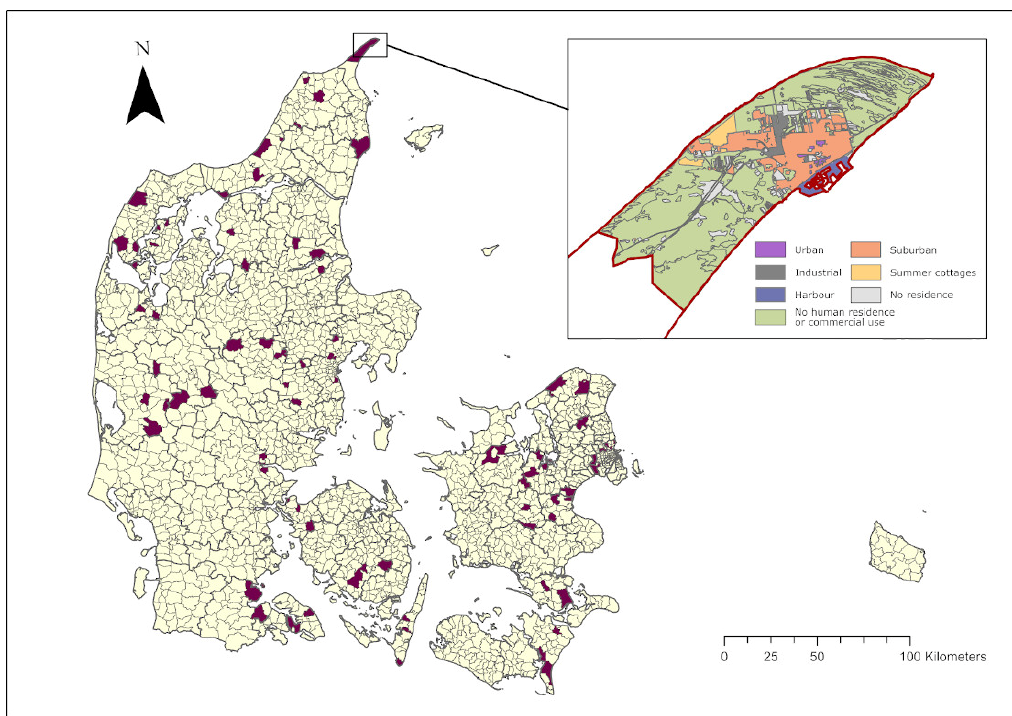
Figure 1. Sampled areas in Denmark (purple)—32 municipalities with 3 parishes in each. Skagen Parish is shown with habitat types. Based on map data provided by The Danish Agency for Data Supply and Efficiency, Copenhagen NV, Denmark, and Danish Municipalities; ‘DAGI’, ‘GeoDanmark’, August 2020 [38].